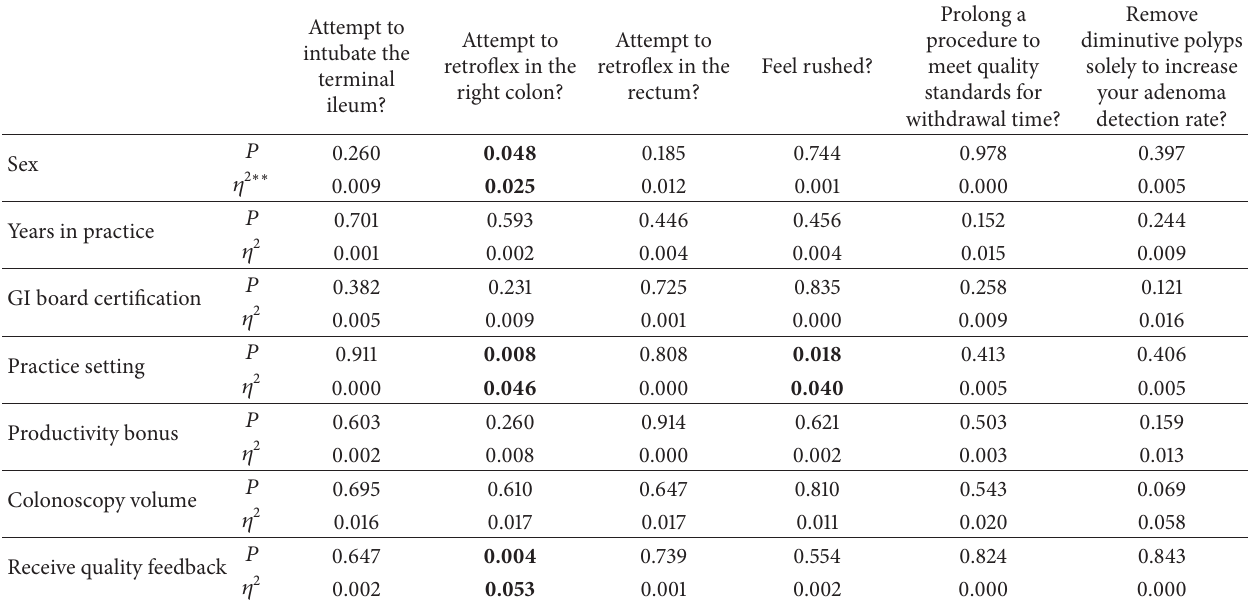
Table 4: While performing screening and surveillance colonoscopies, how often do you . . . ? ∗ .